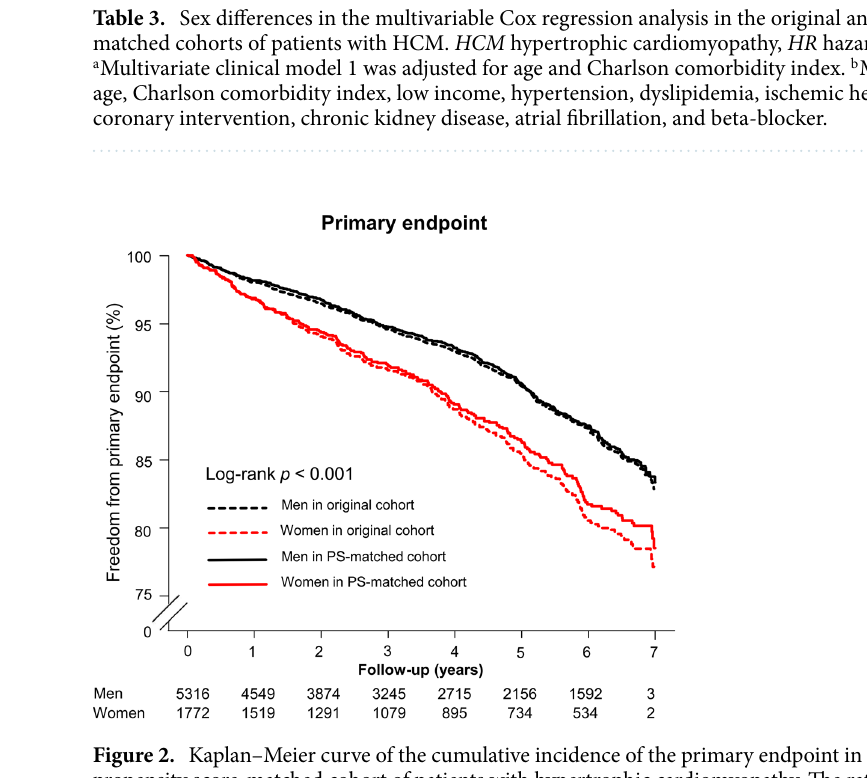
Figure 2. Kaplan–Meier curve of the cumulative incidence of the primary endpoint in the original and propensity score-matched cohort of patients with hypertrophic cardiomyopathy. The rate of occurrence of the primary endpoint, a composite of cardiovascular death or new-onset heart failure, was higher among women than among men, and this result was concordant with that in the propensity score-matched cohort. PS, propensity